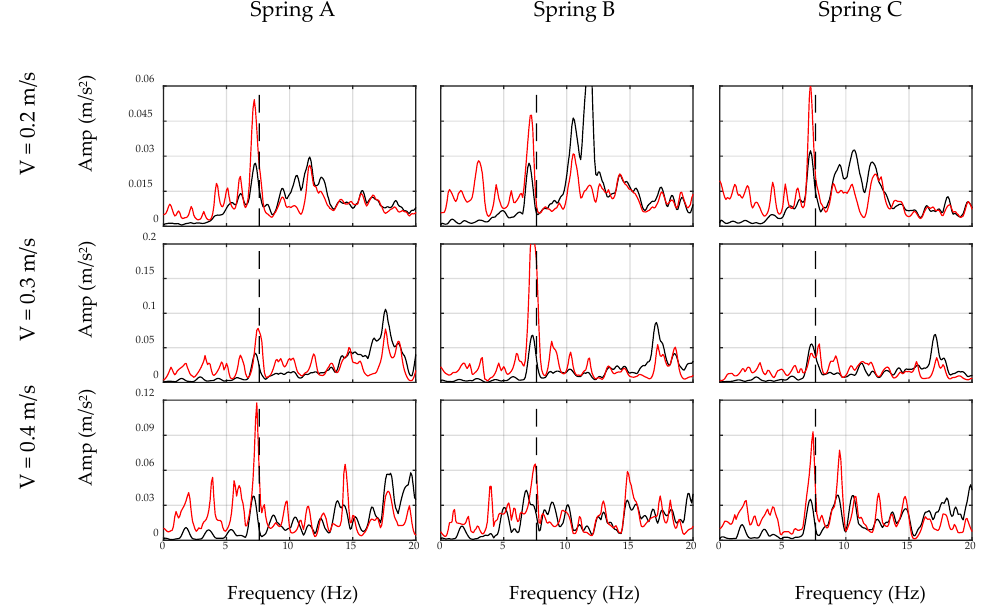
Figure 19. Unfiltered (black) and filtered (red) spectrums of on-bridge data collected by smartphone.